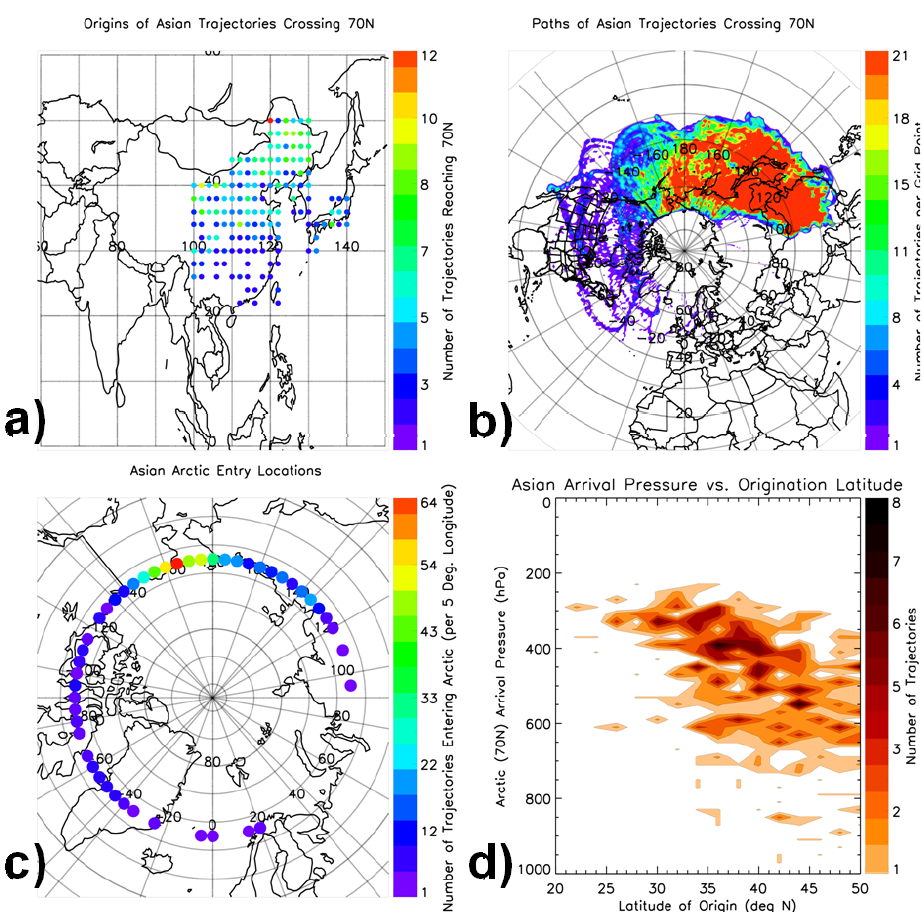
Fig. 4. Trajectory statistics for the eastern Asia domain. (a) Number and originating locations of trajectories reaching the Arctic (70 o N) within 15 days. (b) Pathways taken by all 15 day trajectories reaching the Arctic. (c) Number and location of trajectories entering the Arctic. (d) Pressure level at which Arctic bound trajectories arrive at 70 o N.